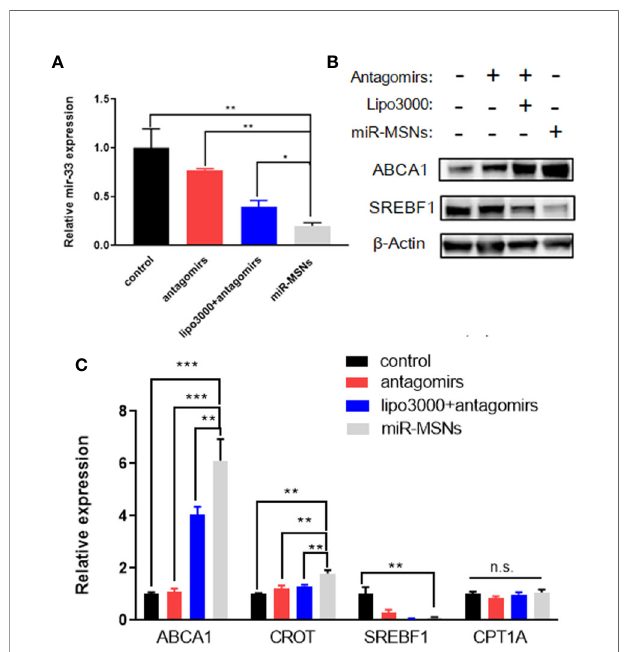
FIGURE 4 | Silencing effect of miR-33 by miR-MSNs and changes in the expression of downstream genes. (A) Expression of miR-33 quanti fi ed by RT-PCR. n=3. (B) Western blot analysis of ABCA1 and SREBF1 protein. (C) Expression of miR-33 downstream genes (ABCA1, CROT, SREBF1, and CPT1A) quanti fi ed by RT-PCR. n=3. *p < 0.05, **p < 0.01, ***p < 0.001. n.s., no signi fi